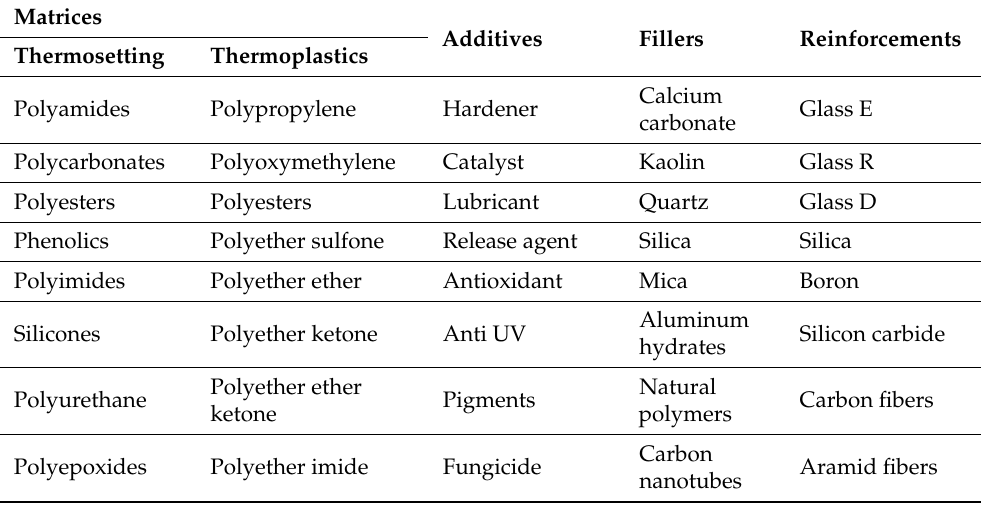
Table 4. List of composite polymeric